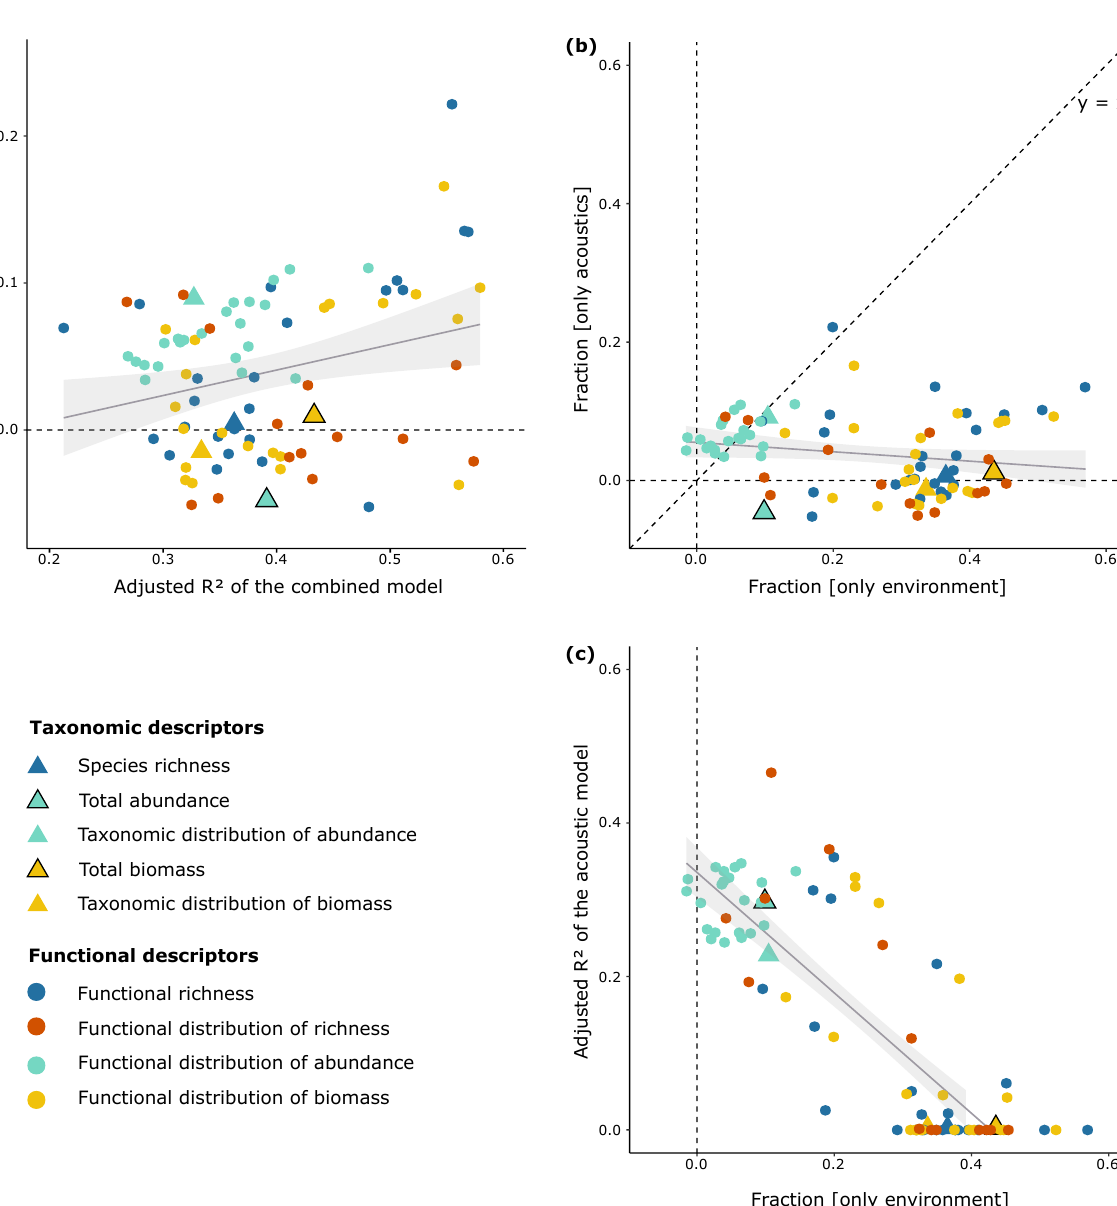
Figure 5. Relationships between ( a ) fraction [only acoustics] and adjusted R 2 of the combined model; ( b ) fraction [only acoustics] and fraction [only environment]; and ( c ) adjusted R 2 of the acoustic model and fraction [only environment]. Fraction [only acoustics]: proportion of the variance of the combined model explained only by acoustic variables; Fraction [only environment]: proportion of the variance of the combined model explained only by environmental variables. Negative values of fractions are interpreted as zeros; they correspond to cases where the explanatory variables explain less variation than random normal variables would (see [46]). Results are shown for the 86 significant combined models (each point represents a fish